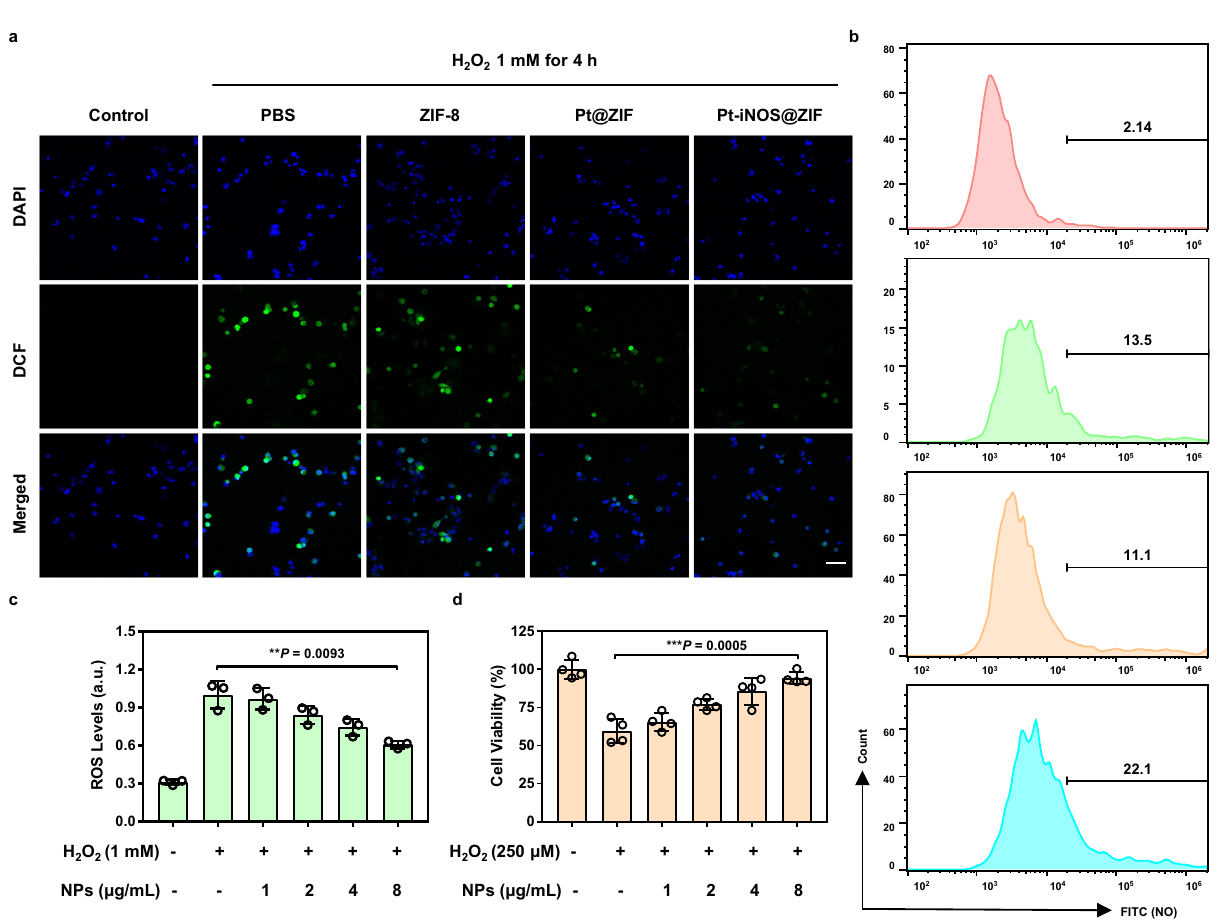
Fig. 4 Antioxidant and cell protection activities in FL83B cells. a Fluorescence images of ROS levels in H 2 O 2 -stimulated hepatocytes pretreated with PBS, ZIF-8, Pt-ZIF and Pt-iNOS@ZIF NPs (8 μ g/mL). Cells were stained with DCFH-DA (green) and Hoechst 33342 (blue) after 4 h incubation. Experiments were performed three times with similar results. Scale bar: 50 μ m. b Flow cytometry analysis of NO levels with various treatments. The values indicate the percentage of cells staining with NO indicators out of total cells in the selected gate. c ROS levels H 2 O 2 -stimulated hepatocytes pretreated with different concentrations of Pt-iNOS@ZIF (0, 1, 2, 4, 8 μ g/mL) (n = 3 biologically independent samples). d Cell viability in hepatocytes stimulated with H 2 O 2 for 24 h in the presence of Pt-iNOS@ZIF (0, 1, 2, 4, 8 μ g/mL) (n = 4 biologically independent samples). For c , d data presented as means ± s.d. one-tailed unpaired t-test. ** P < 0.01, *** P <